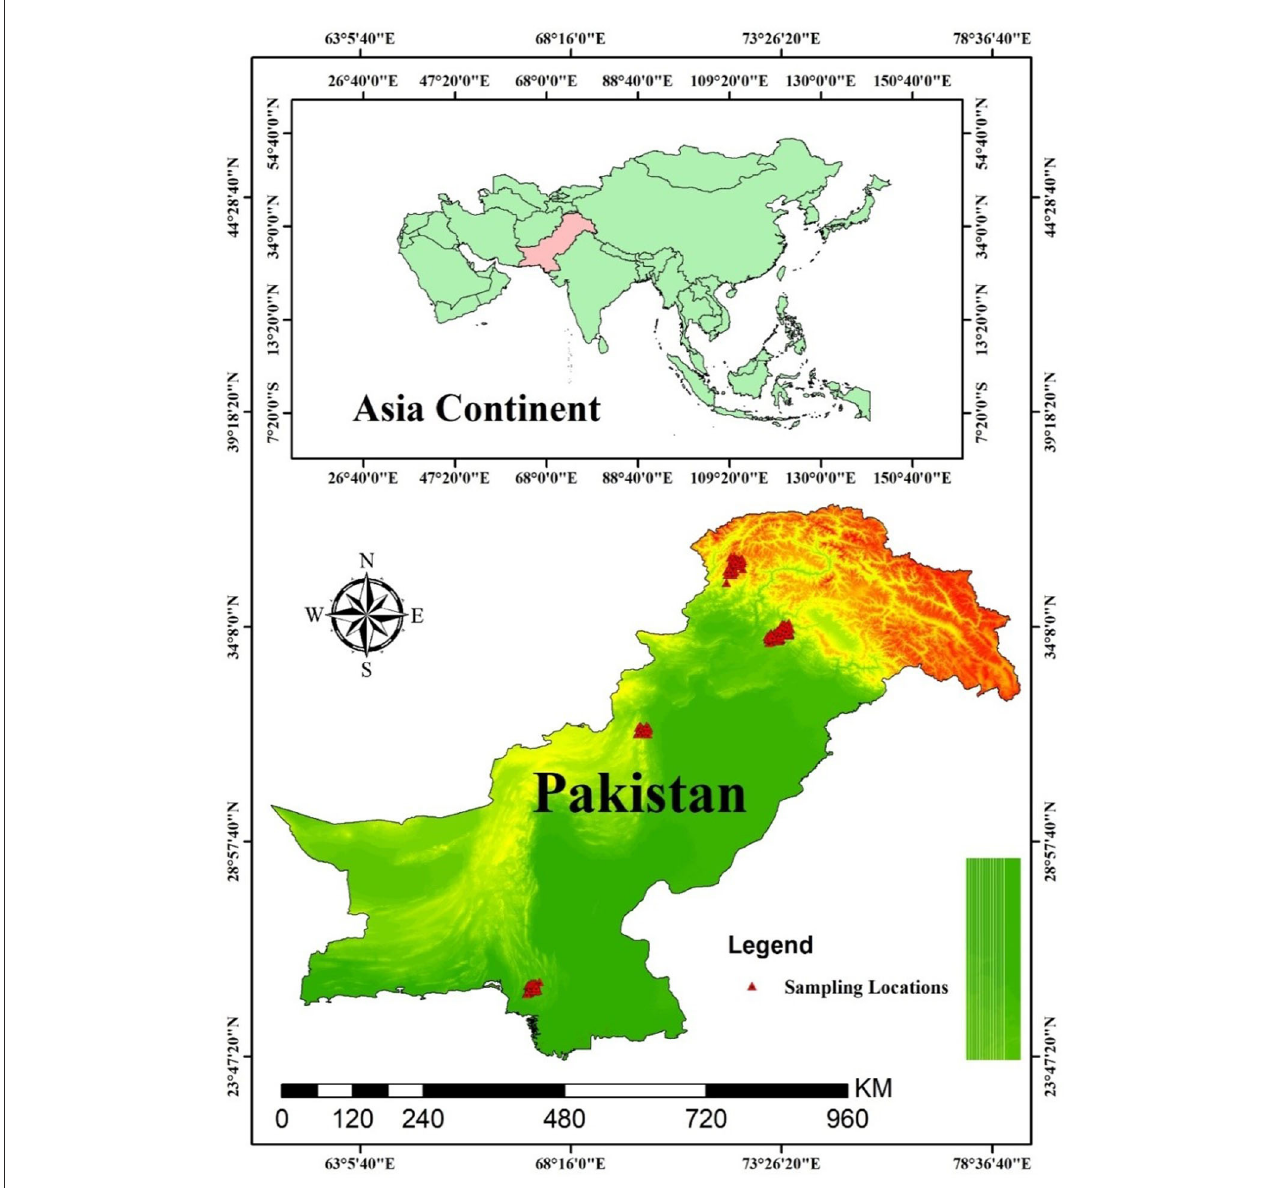
FIGURE2 GIS-generated map of the studied forests across Pakistan.